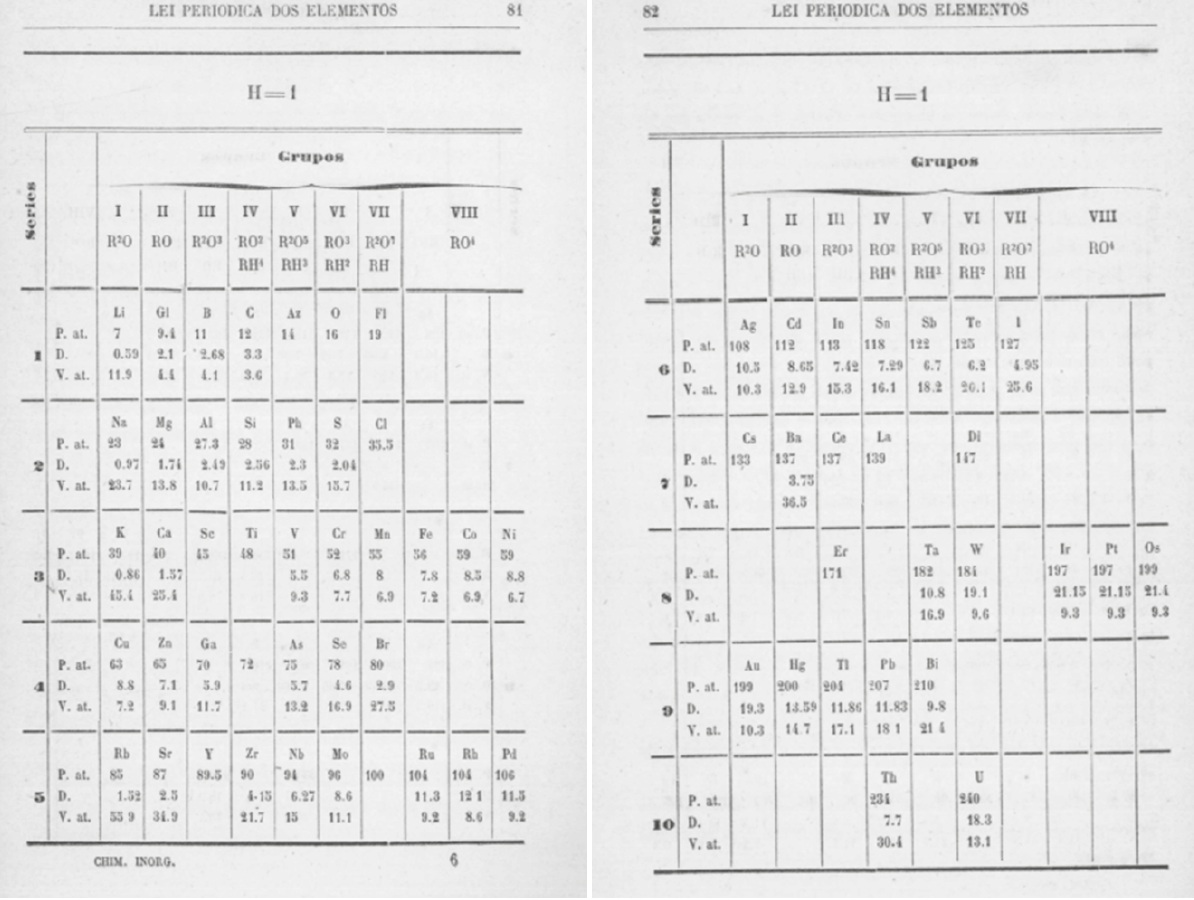
Figure 2. Possibly the first periodic table published in a Portuguese university textbook. Francisco Augusto Corrêa Barata’s book, 1880 (ref. 44, pp.